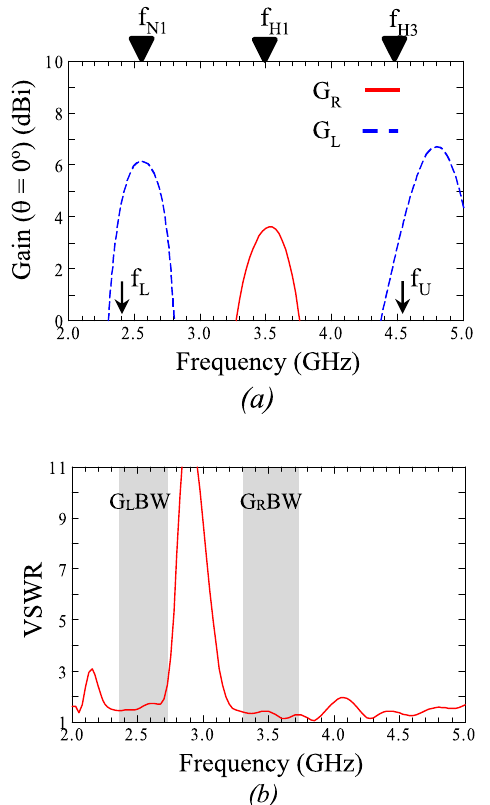
Fig. 25. Frequency response for the square metaloop-N antenna (SQR-MTLP-N). (a) Gain. (b) VSWR.